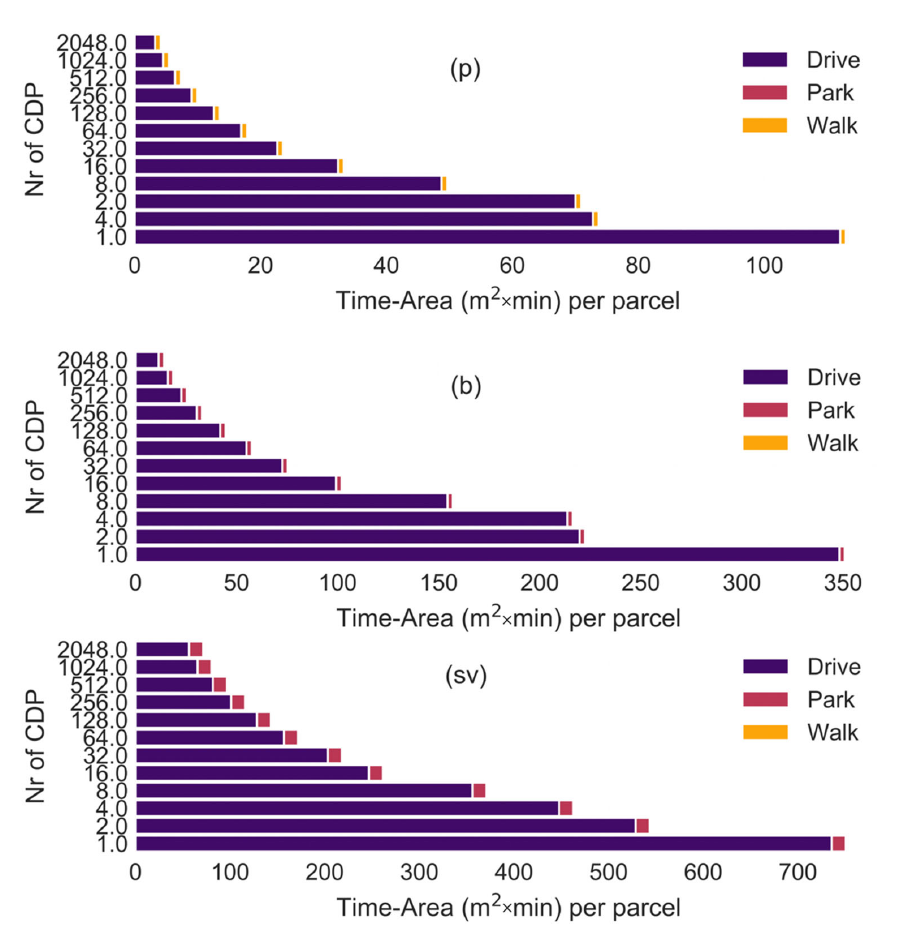
Figure 6. Time ‐ area requirements of trips to lockers by customers (p) pedestrians, (b) bicycles, (sv) small vehicles. Number of CDPs varied from 1 to 2048.